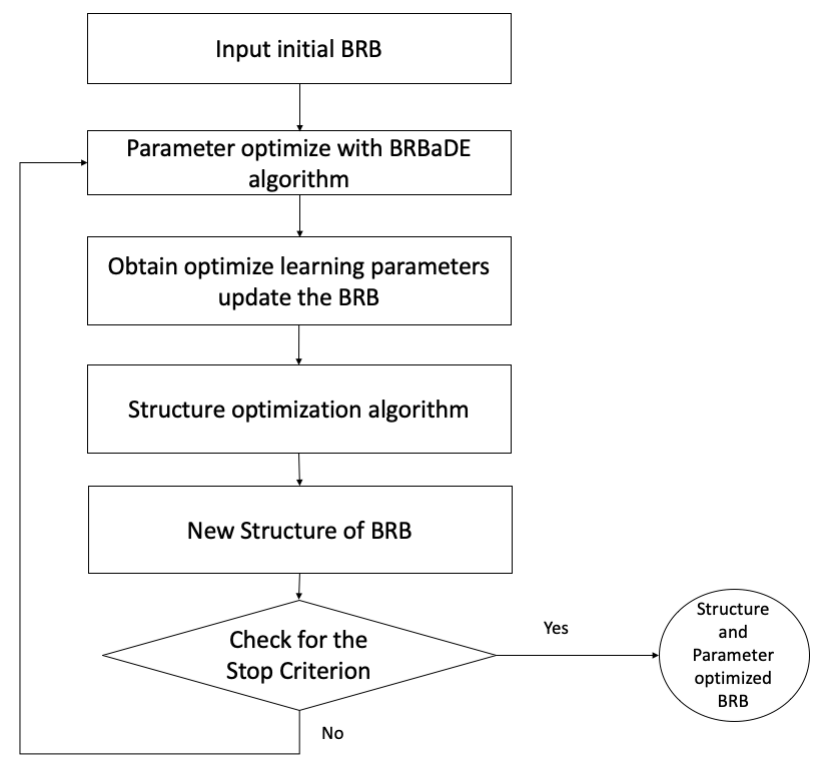
Figure 6. Flowchart of BRBaDE-based